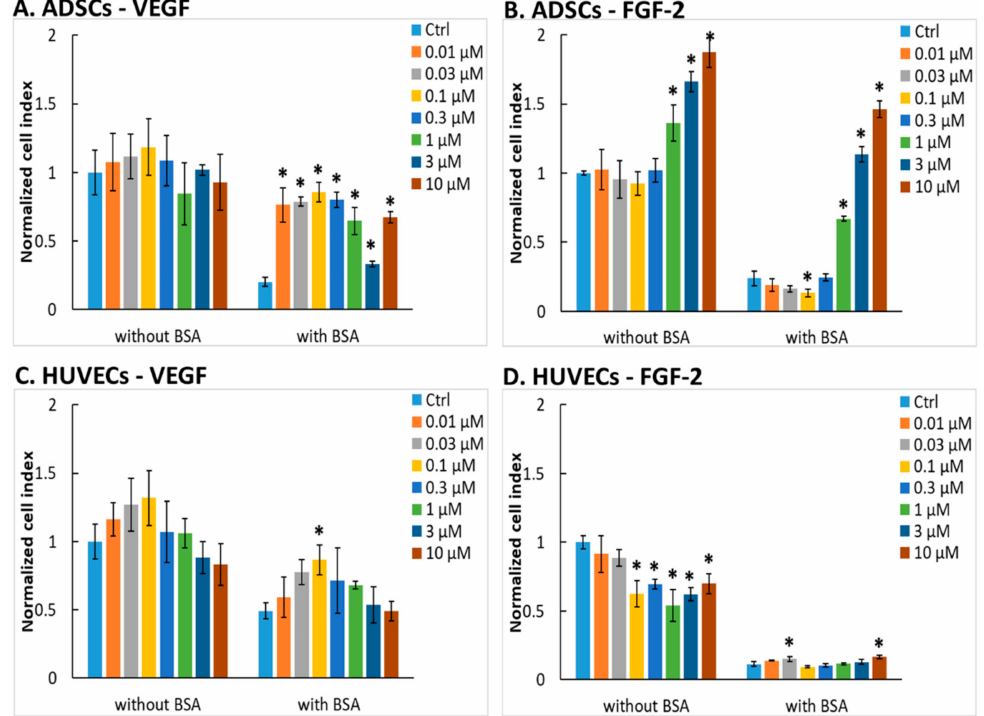
Figure 6. Initial adhesion of ADSCs ( A , B ) and HUVECs ( C , D ) 4 h after seeding into wells of E- plates in the xCELLIgence system pre-adsorbed with VEGF-A 165 ( A , C ) or with FGF-2M ( B , D ) in concentrations from 0.01 to 10 µ M. The wells were either left unblocked, i.e. without bovine serum albumin (BSA) or were blocked with 0.5% BSA (with BSA). Cell index values were normalized to the control sample without adsorbed growth factors and BSA (Ctrl without BSA). Mean ± SD from 3 wells. Holm-Sidak method, p ≤ 0.05. The statistical comparison was made amongst the samples with or without BSA. * statistically significant difference in comparison with the control sample